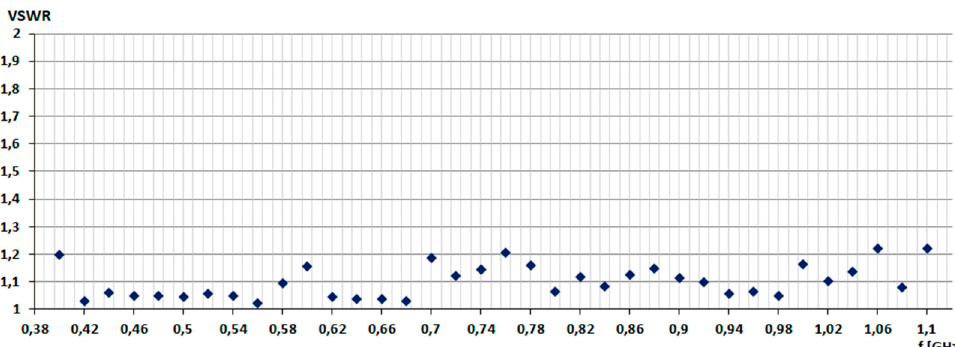
Figure 3. VSWR in the frequency range from 400 MHz to 1100 MHz.